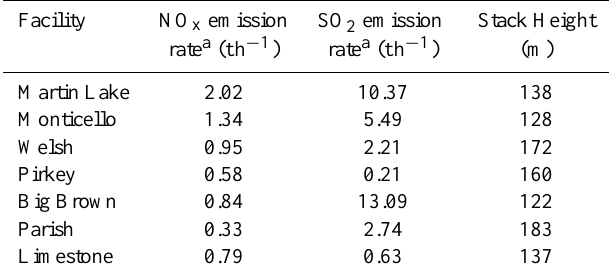
Table 1. Major power plants in eastern